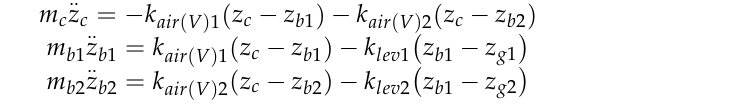
Figure 6. Stewart platform displacement with respect to the given guideway irregularity: ( a ) vertical direction, ( b ) lateral direction. Table 3. Guideway irregularity following error of Stewart platform.